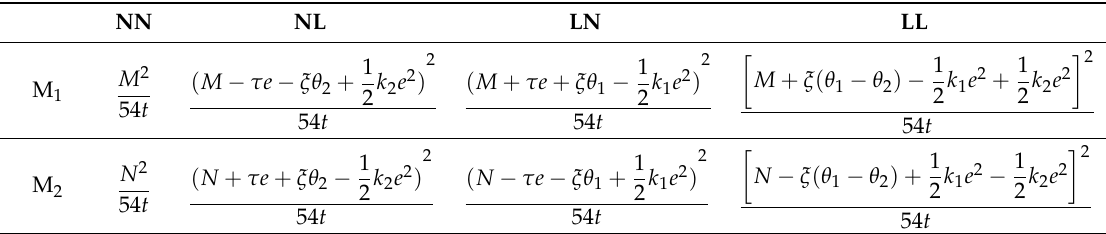
Table A5. Equilibrium profit of the two manufacturers under the four